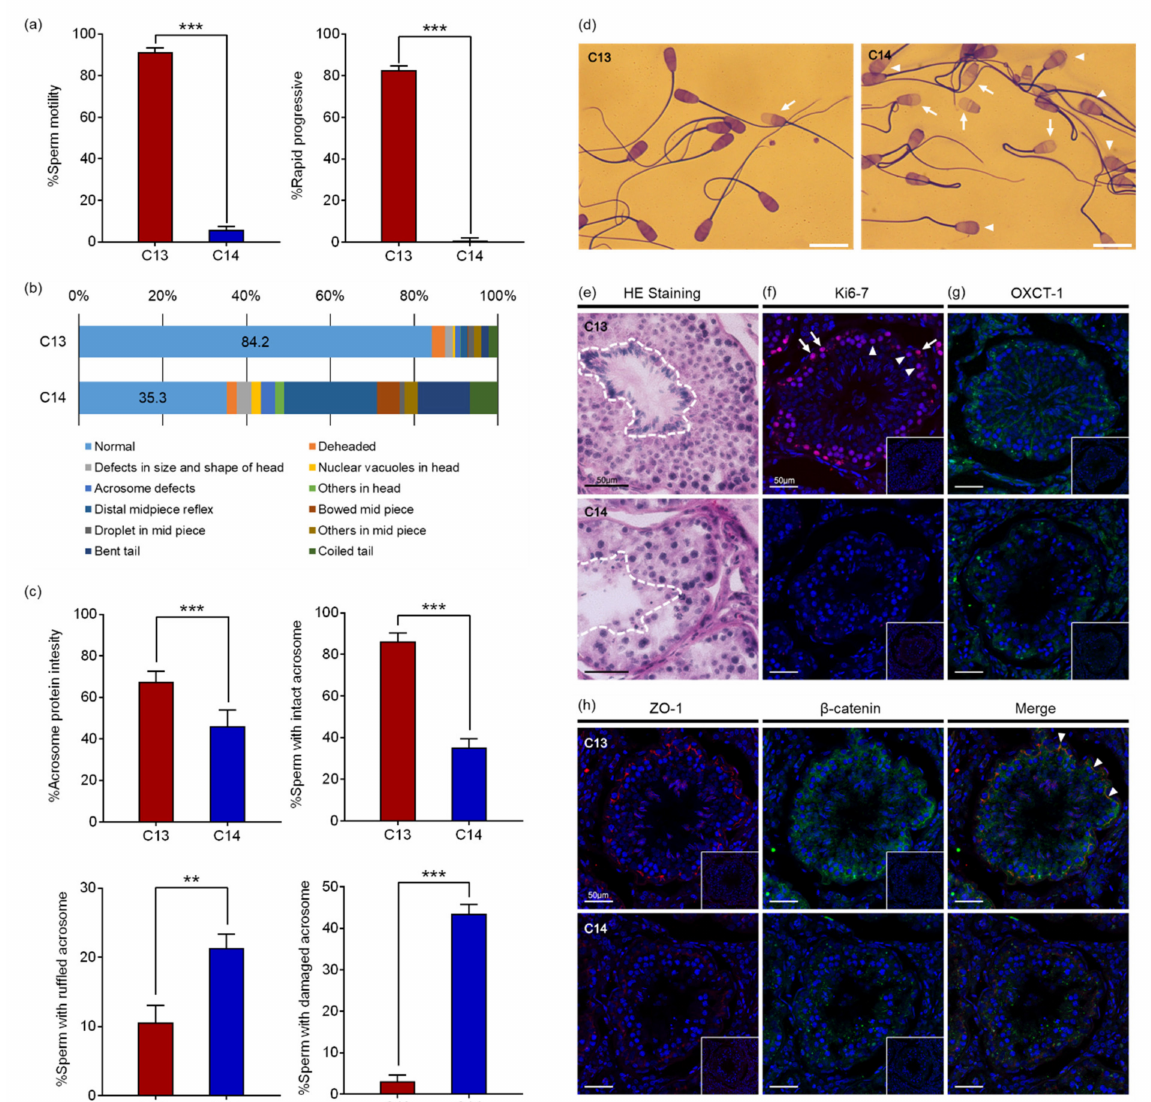
Figure 1. Poor sperm index of infertile C14 sperm. ( a ) Sperm motility and progressiveness by computer-assisted sperm analysis (CASA). Red bars indicate motility and progressiveness of C13 sperm and blue bars for C14 sperm. *** p < 0.001 vs. C13. ( b ) Morphological evaluation of sperm. Relative stacked bar chart shows the relative percentage of morphological parameters of sperm in head, midpiece, and tail. Each parameter is depicted in different color. Numbers in the light blue bar indicate the percentage of normal sperm in each group. ( c ) Morphological evaluation of sperm head. Red bars indicate structural parameters of C13 sperm head and blue bars for C14, those including acrosome stain and acrosomal intactness. ** p < 0.01, *** p < 0.001 vs. C13. ( d ) Representative image of sperm. Arrowheads indicate sperm with ruffled acrosomes and arrows for sperm with damaged acrosomes. Scale bar represents 20 µ m. ( e ) Histological comparisons of testes by hematoxylin and eosin (H&E). The area containing elongating spermatid is circled with white dashed lines. ( f , g ) Confocal immunofluorescence (IF) microscopy of testis sections from C13 and C14. Anti-Ki67 (red) and anti-OXCT1 (green) antibodies were used. Arrows and arrowheads indicate spermatogonia and primary spermatocytes, respectively. ( h ) Testis was double labeled for zonula occludens 1 (red) and β -catenin (green). Arrowheads indicate co-localization of ZO-1 and β -catenin. Inserts show negative controls. Scale bar represents 50 µ